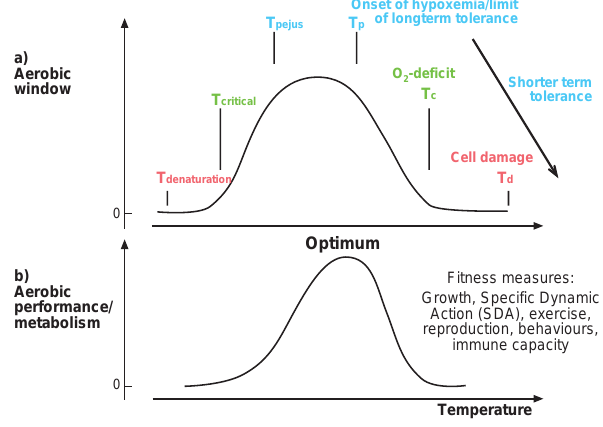
Fig. 2. Conceptual model of how ocean warming and hypoxia, as interacting stressors, shape the thermal window of performance of a species, population or life stage, based on the concept of oxygen and capacity limited thermal tolerance (after P¨ortner and Knust, 2007; P¨ortner et al., 2009). Optimized oxygen supply to tissues between low and high pejus temperatures ( a ) combined with the kinetic stim- ulation of performance rates by warming supports temperature de- pendent performance and a functional optimum (i.e. an optimum of aerobic scope) close to upper pejus temperature ( b ). This re- flects fitness due to functional capacity in ecosystem level processes such as competition, foraging, immune response, growth and be- haviours. Ambient hypoxia causes a narrowing of thermal windows and possibly, lower performance optima due to lower functional ca- pacities at reduced systemic oxygen tensions. The graph depicts acute performance levels and limitations in response to short term temperature fluctuations. On longer time scales, changing tempera- tures elicit acclimatization as a limited shift of performance optima and limits on the temperature scale. Note that the passive tolerance range (starting beyond pejus temperatures) is a relevant component of the niche in some cases, when it is exploited for a limited time under extreme conditions, e.g. in invertebrates exposed to combined hypoxia and temperature extremes in the intertidal zone. Hypoxia tolerance is at a maximum in the thermal optimum, due to optimal oxygen supply capacity causing Pc to be minimal. Hypoxia sensi- tivity is enhanced at thermal extremes (Tc) when oxygen supply ca- pacity falls in relation to oxygen demand, and the Pc rises towards its maximum, indicated by the onset of anaerobic metabolism at critical temperatures and ambient, even normoxic oxygen